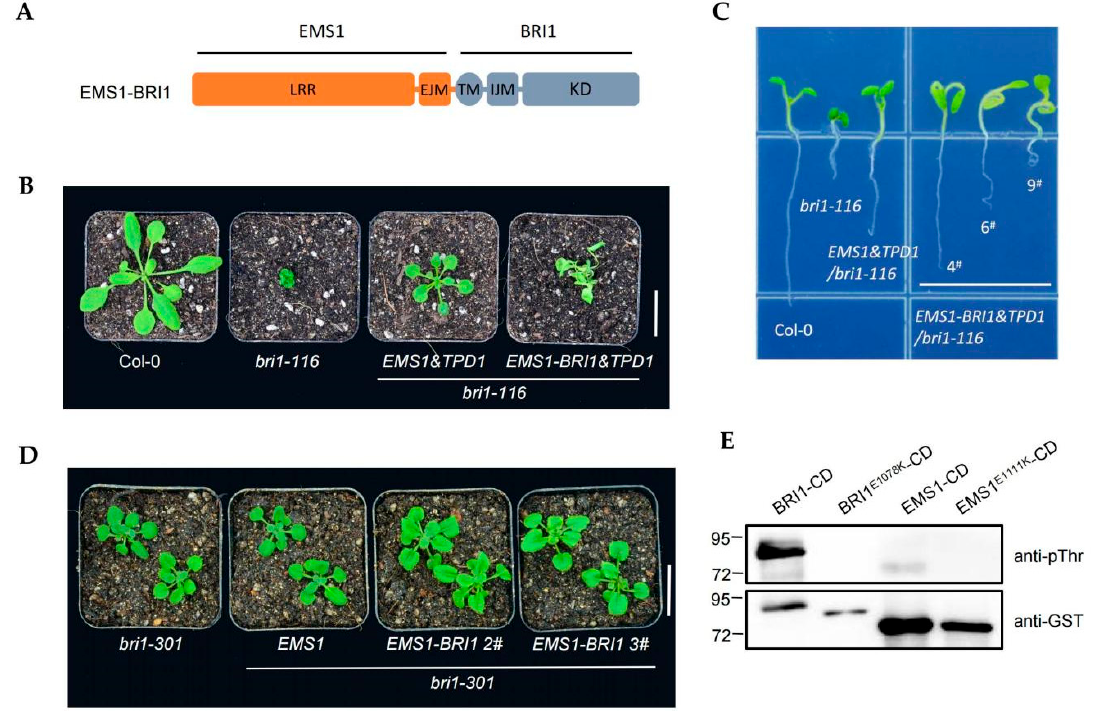
Figure 3. Comparing the kinase activity of EMS1 and BRI1. ( A ) Schematic diagram of chimeric receptor EMS1-BRI1. The extracellular domains of EMS1 fused with the intracellular domains of BRI1. BRI1 and EMS1 protein structures were labeled in gray and orange, respectively. ( B ) Phenotypes of 4-week-old transgenic lines expressing EMS1&TPD1 and EMS1-BRI1&TPD1 in bri1-116 background. Scale bar, 2.0 cm. ( C ) 7-day-old seedlings grown on 1/2 MS medium. ( D ) Phenotypes of 4-week-old bri1-301 mutants and transgenic lines expressing EMS1 and EMS1-BRI1 in bri1-301 background. Scale bar, 2.0 cm. ( E ) In vitro assay of the kinase activity of recombinant proteins BRI1-CD, BRI1E1078K-CD, EMS1-CD, and EMS1E1111K-CD. Phosphorylation changes were analyzed by pThr antibody. GST served as the loading